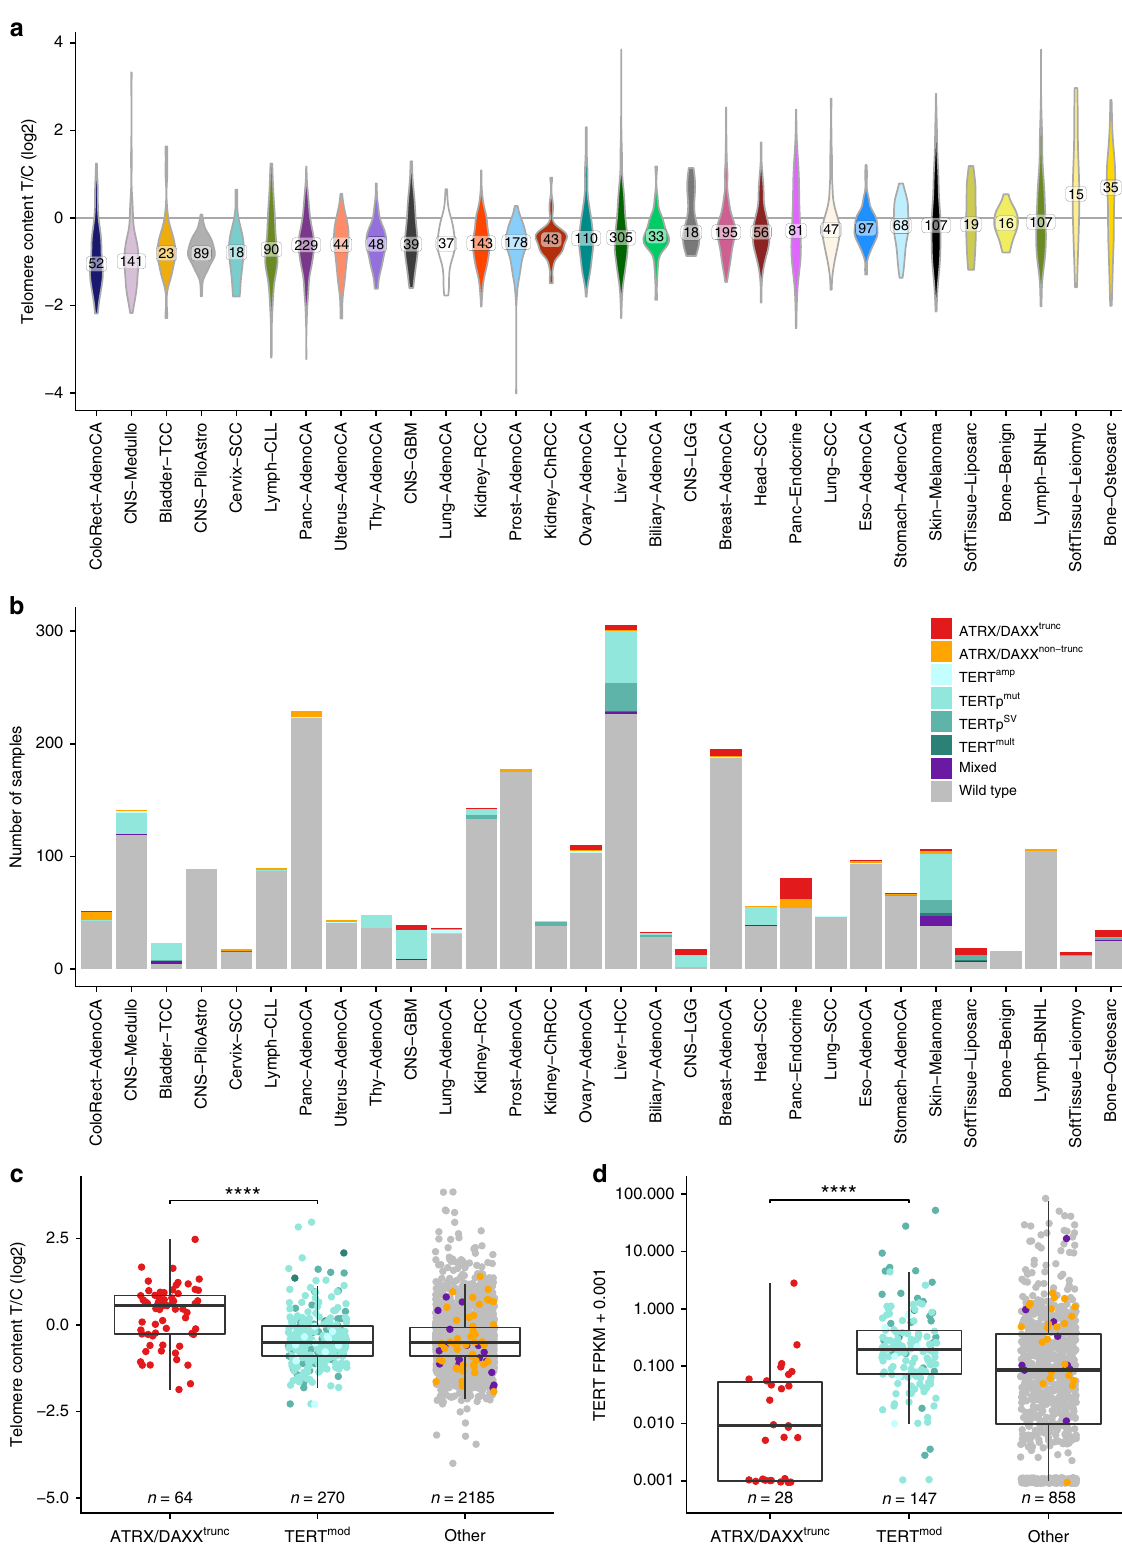
Fig. 1 Telomere content is increased in ATRX/DAXX trunc samples. a Overview of the telomere content distribution of all analyzed tumor types. The number of samples in each tumor type is indicated. Cohorts with sample sizes <15 are not shown. b TMM-associated mutations in different tumor types. c Telomere content in samples with different TMM-associated mutations. d TERT expression in samples with different TMM-associated mutations. The center lines of the boxplots are the medians, the bounds of the boxes represent the fi rst and third quartiles, the upper and lower whiskers extend from the hinge to the largest or smallest value, respectively, no further than 1.5 × IQR from the hinge (where IQR is the interquartile range, or distance between the fi rst and third quartiles). **** p < 0.0001, Wilcoxon rank-sum